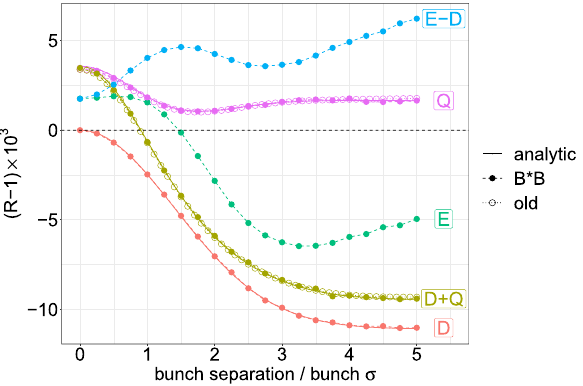
Fig. 10 ( R − 1 ) × 10 3 correction for the bunches with the parameters from Table 1 colliding at one interaction point versus their separation in the x -scanexpressedinthebunchwidths.Thesolidpointsaretheresults of the B*B simulation when in the recurrence relation (3.10) the exact formula (E), dipole constant dependent on the separation (D) or their difference (E-D) are used. The open circles show the tabulated values from the old simulation with the quadrupole kick (Q) and their sum with the values from the dipole analytic formula (D+Q). The curves are analytic predictions for the dipole (D), quadrupole (Q) kicks and their sum